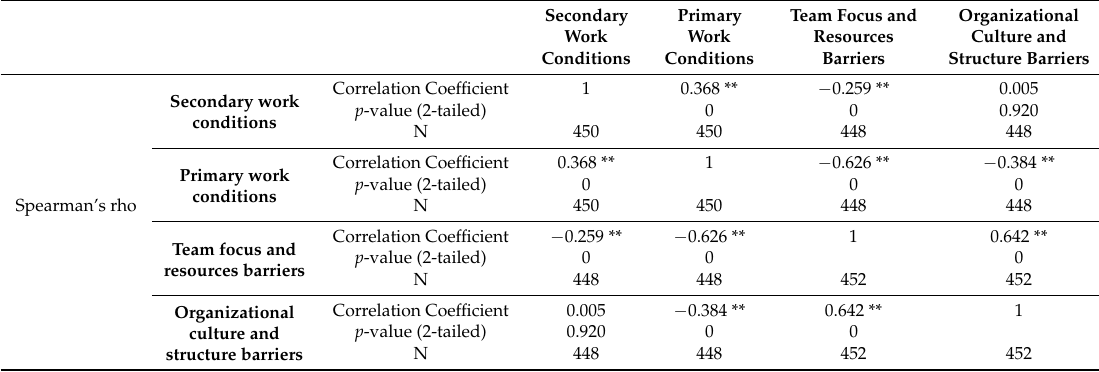
Table 5. Correlations between job characteristics and obstacle